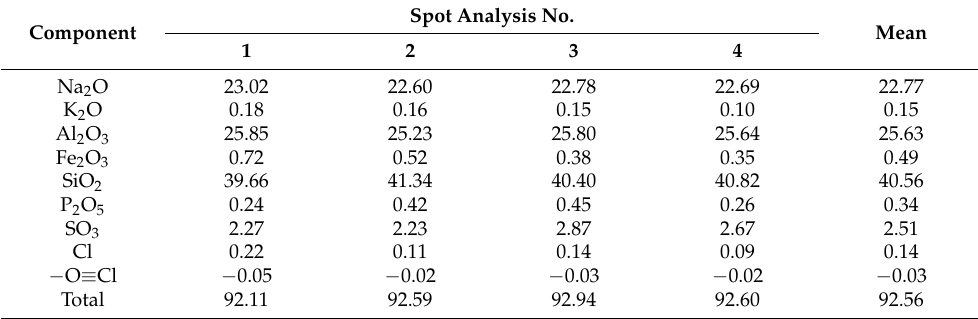
Table 1. Chemical composition (wt.%) of S- and P-bearing cancrisilite (Sample 3).